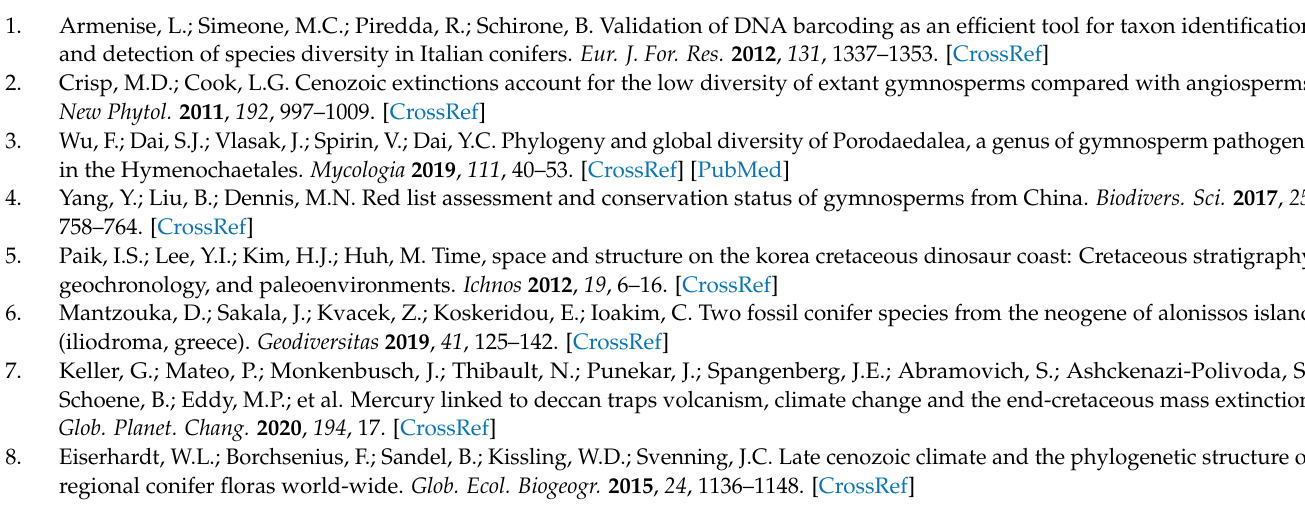
Figure S3: avg.test.or10pct; Figure S4: avg.test.orMTP; Figure S5: delta.AICc; Figure S6: Analysis of omission commission; Figure S7: the receiver operating characteristic (ROC) curve; Figure S8: Average response curves of eight predictor variables of the modeled distribution of G . pensilis based on the MaxEnt model. (A) Bio1; (B) Bio2; (C) Bio6; (D) Bio9; (E) Bio12; (F) Bio14; (G) Bio15; (H) Bio18. The variable codes are the same as those in Table 1; Figure S9: Jackknife test for the importance of environmental variables.(A) Reguarized training gain; (B) Test gain; (C) AUC; The variable codes are the same as those in Table 1; Figure S10: Photos of G . pensilis in different areas of Fujian Province; Table S1: 27 species presence data for MaxEnt modeling; Table S2: Evaluation metrics of Maxent model generated by ENMeval; Table S3: The mean area under the curve (AUC) from 10 replicate models of Glyptostrobus pensilis under three past, present and eight future climate scenarios; Table S4: Change rate of suitable habitats areas of G . pensilis under different climate